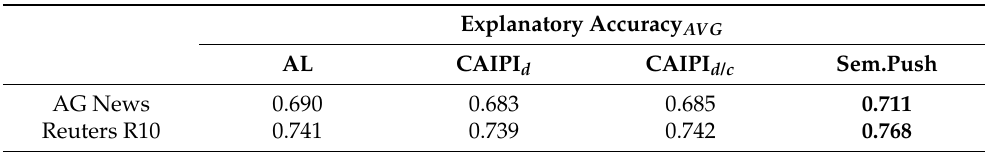
Table 3. Local explanation quality with respect to ‘Ground Truth’ of downstream classification tasks (with XGBoost as the base learner).